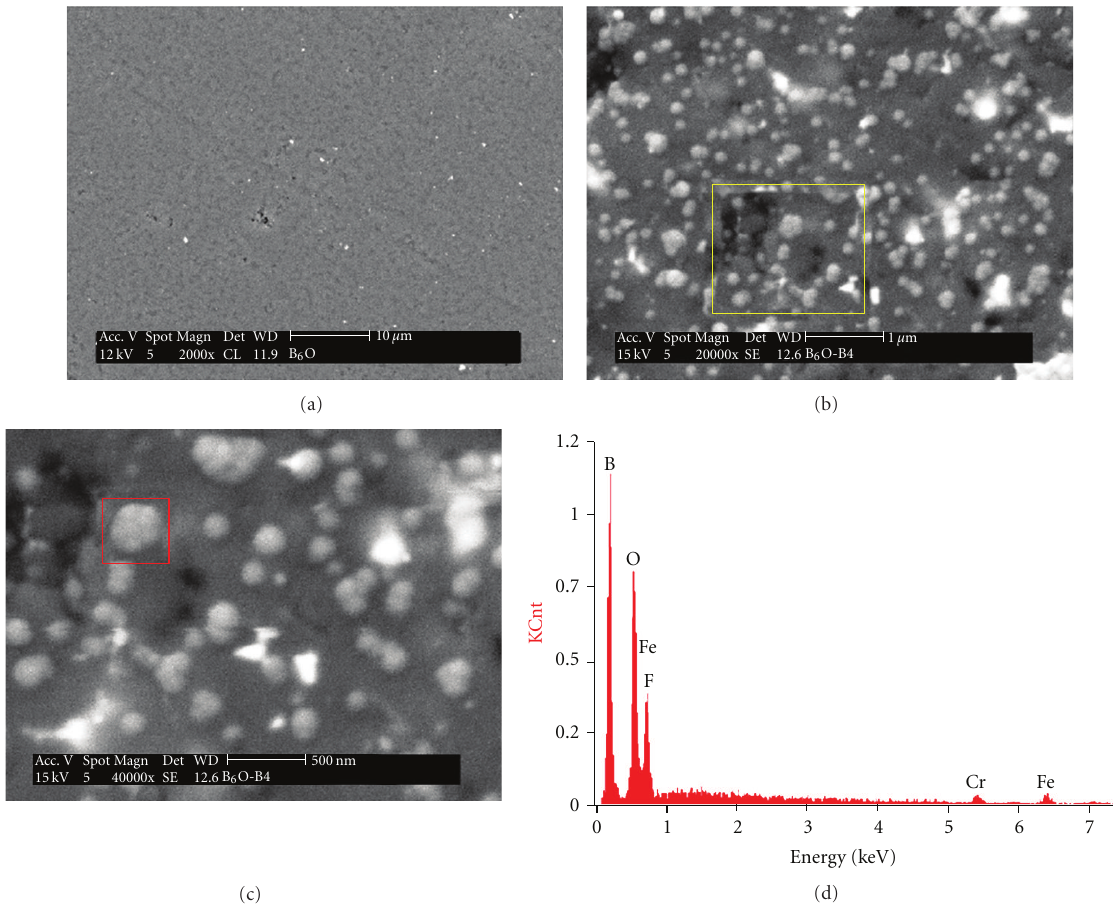
Figure 2: A depiction of SEM images measured on the surface of (a) an unimplanted B 6 O specimen, ((b) and (c)) a 5 . 0 × 10 15 F + ions/cm 2 implanted B 6 O specimen showing clusters of particles embedded in the samples synthesized by fluorine-ion-beam implantation, and (d) an EDX measured pattern on one such ion-beam-synthesized cluster which is highlighted in micrograph